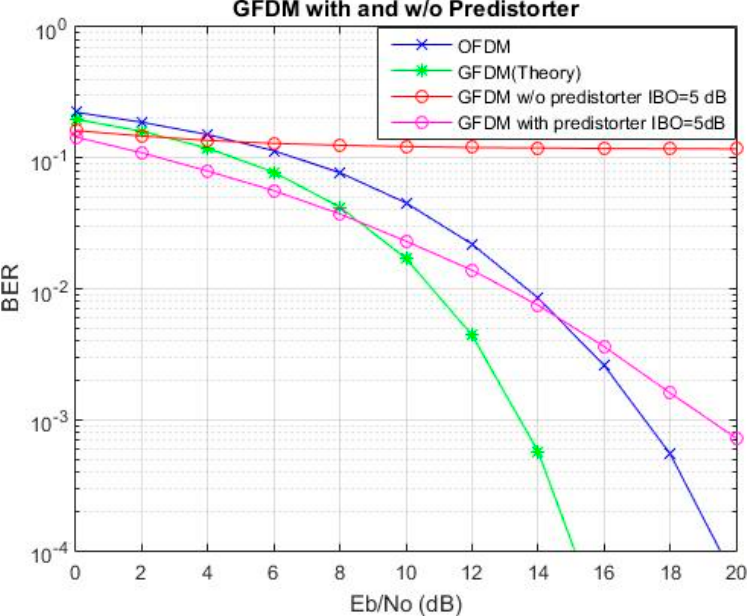
Electronics 2019 , 8 , 620 Figure 14. Comparison of GFDM with and without predistorter. Figure 14. Comparison of GFDM with and without predistorter.